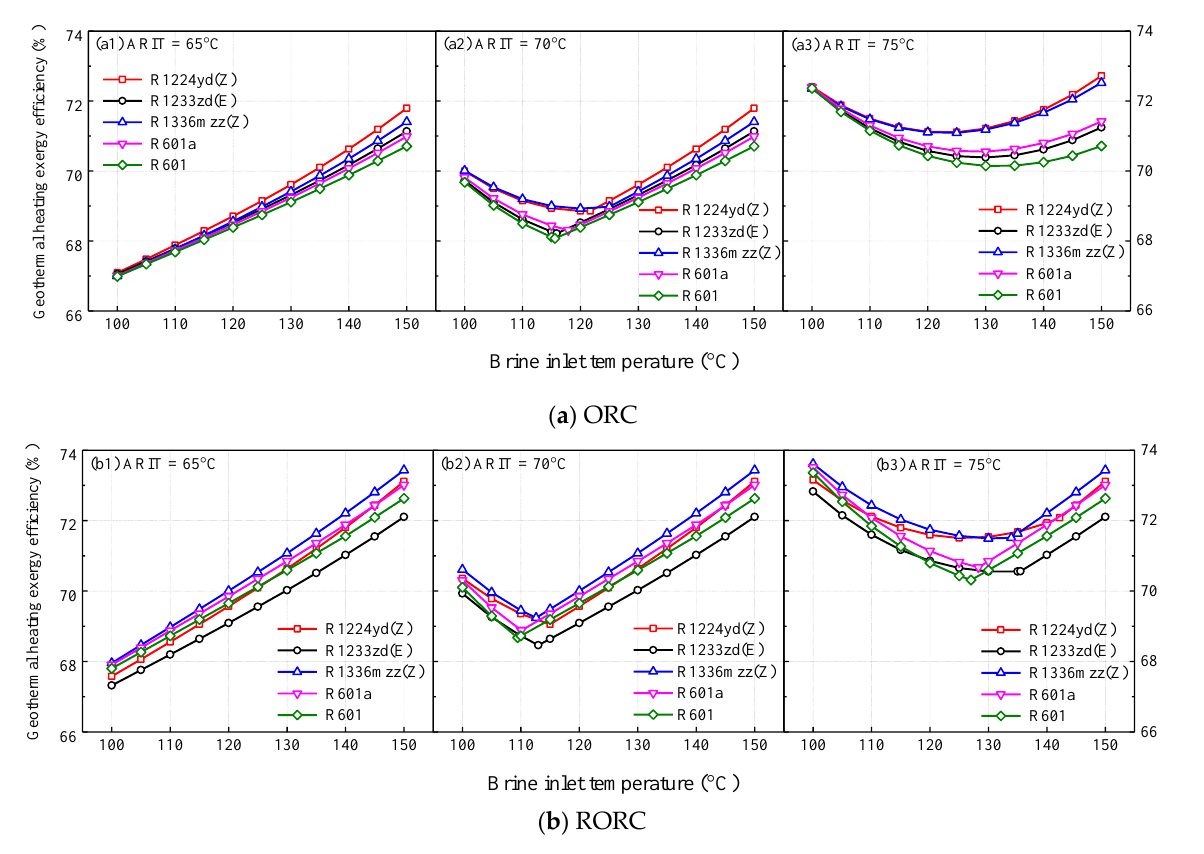
Figure 8. Geothermal heating exergy efficiencies for ( a ) ORC and ( b ) RORC at the optimal conditions for various ARITs and BITs.